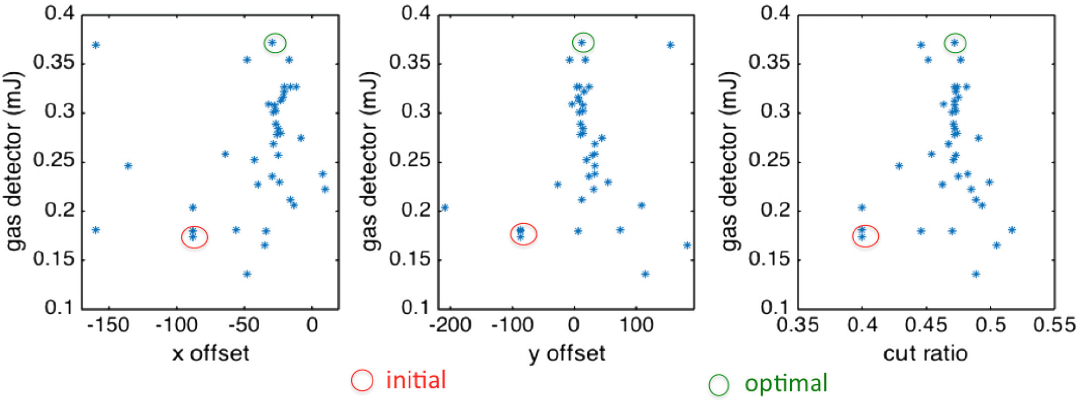
FIG. 5. Left: initial beam profile corresponding to 175 μ J. Middle: optimal beam profile corresponding to 372 μ J. Right: gas detector reading evolution through 39 iterations.